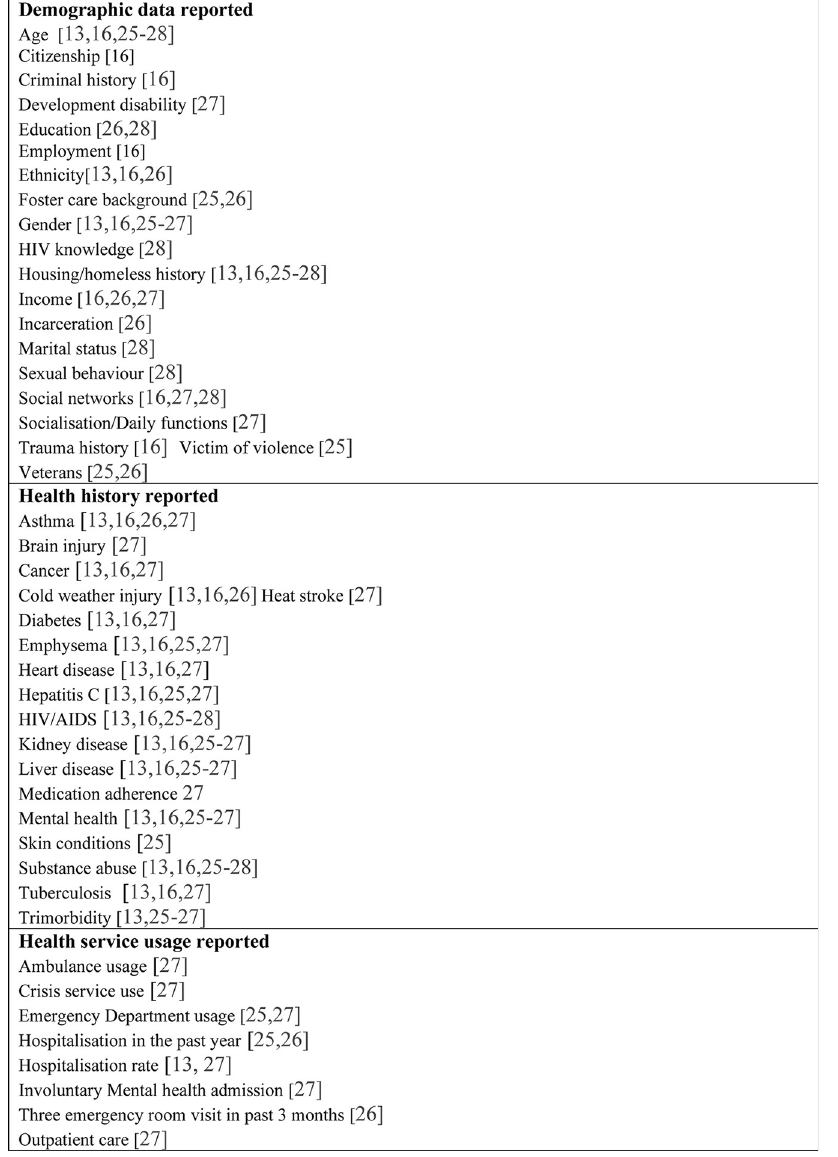
Fig 3. Characteristics of vulnerability indices reported in the included